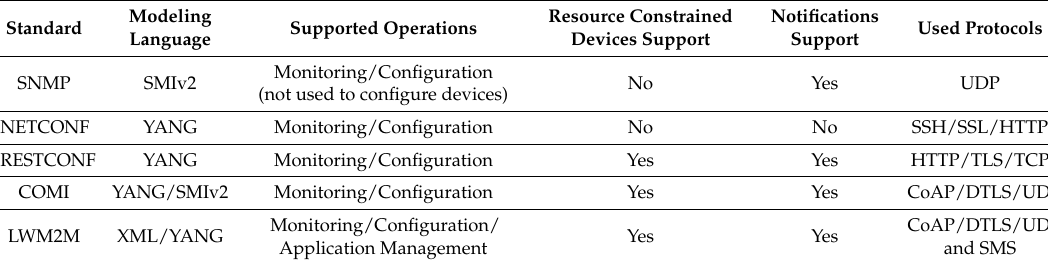
Table 3. Network management protocols